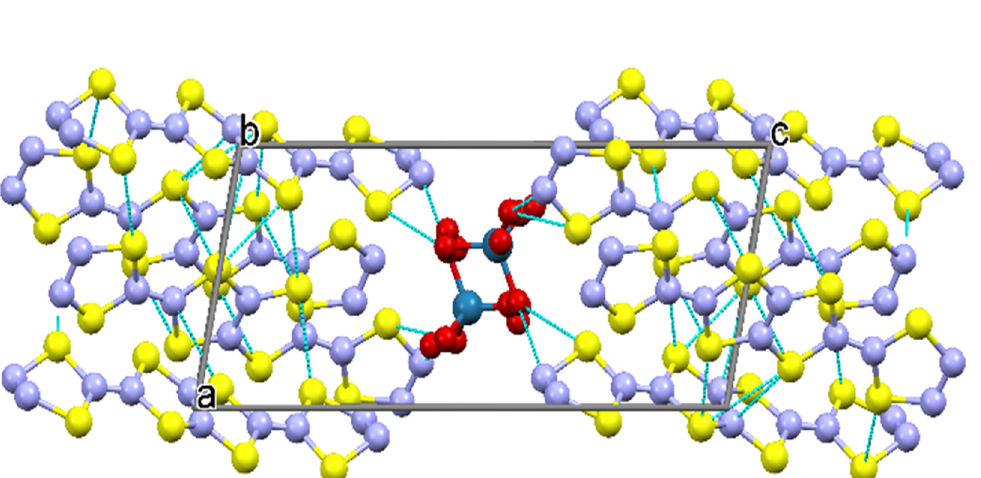
Table 4. The lengths of C=C bonds in the dimer and single radical cation of salt 3 .